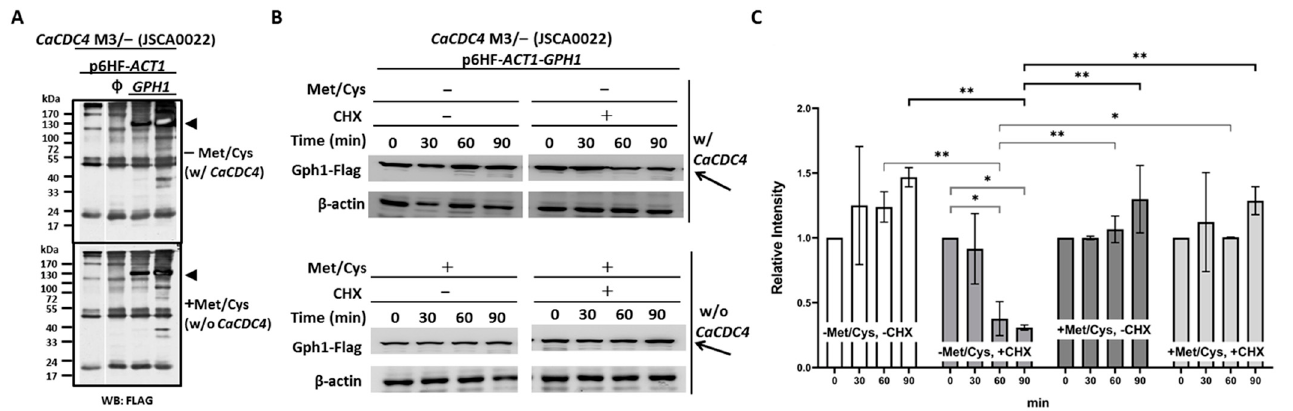
Figure 2. Gph1 protein level decreases in the presence of Ca Cdc4 in C. albicans. ( A ) Cells of strains, as indicated, were grown in SD with or without 2.5 mM Met/Cys. Triangles indicate the migrated position of Gph1 protein. The “ ϕ ” represents empty plasmid p6HF- ACT1 p. ( B ) Cells of strain CaCDC4 M3/– carrying p6HF- ACT1-GPH1 were grown in SD with or without 2.5 mM Met/Cys and in the presence or absence of cycloheximide (CHX) for the indicated time. Arrows indicate the Gph1 protein. Cells of all strains were collected and subjected to Western blotting analysis after growing in the indicated condition. SD donates synthetic defined medium. The anti-FLAG antibodies used as the Gph1 are tagged with FLAG. The β -actin used as a loading control was detected by the anti- β -actin antibody. ( C ) To quantify the protein levels, two independent experiments, including the one in ( B ), were used. The Gph1 levels were normalized to those of β -actin and expressed as the relative intensity. Statistical analyses were performed by one way ANOVA, with * p < 0.05 and ** p < 0.01 as indicated. Representative data from one of the three independent experiments are shown.